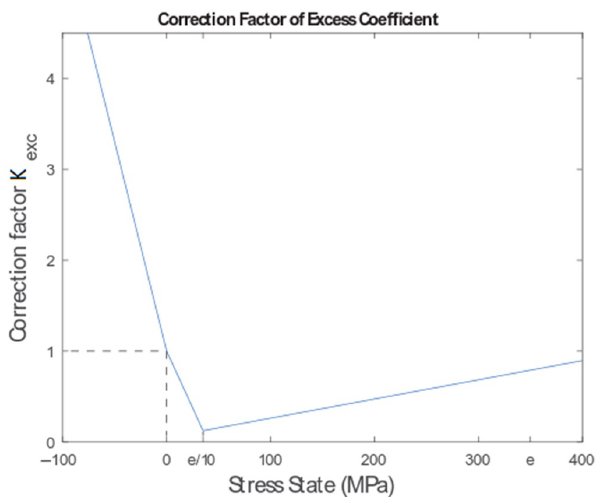
Figure 6. Approximated uni-axial relation between the stress correction factor of V0-parameter Kexc and the stress state [14]. K exc reaches a minimum of 10% of the stress-free permeability at a stress state of 10% of the material elastic limit e. This figure is valid for a material with elastic limit = 350 MPa.